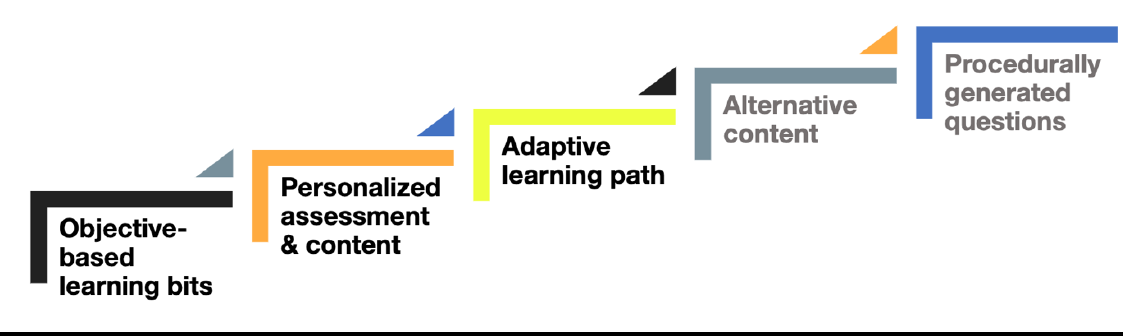
Figure 2. UCF’s adaptive learning design framework with five key